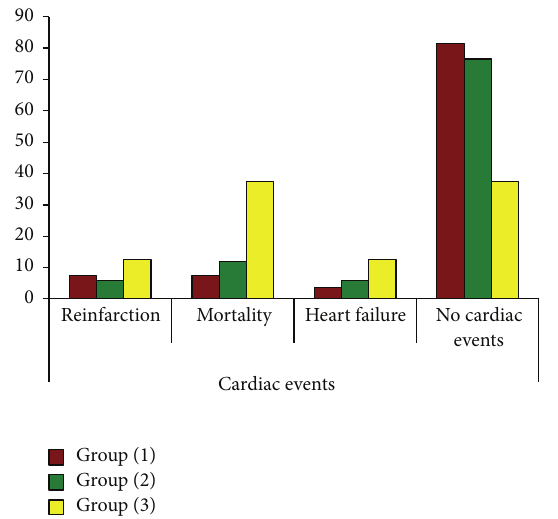
Figure 4: Adverse cardiac events in the study groups (1, 2, and 3).